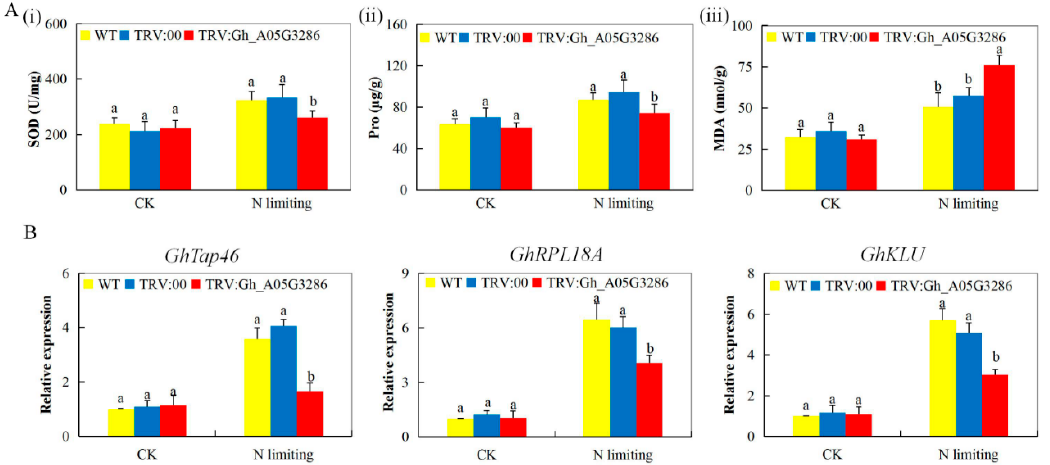
Figure 6. Evaluation of biochemical components, oxidant and antioxidant enzyme concentration levels in Gh_A05G3286 (NLP5) . ( A ) (i): Quantitative determination of SOD concentration. ( ii ): Quantitative determination of proline concentration. (iii): Quantitative determination of MDA concentration ( B ) (i–iii): Stress responsive transcription analysis of the various plants exposed to N-limited conditions for 15 days. Letters a/b indicate statistically significant differences (two-tailed, p < 0.05). The GhActin gene was used as internal control. The error bars of the Gh_A05G3286 (NLP5) gene expression level represent the standard deviation of three biological replicates.